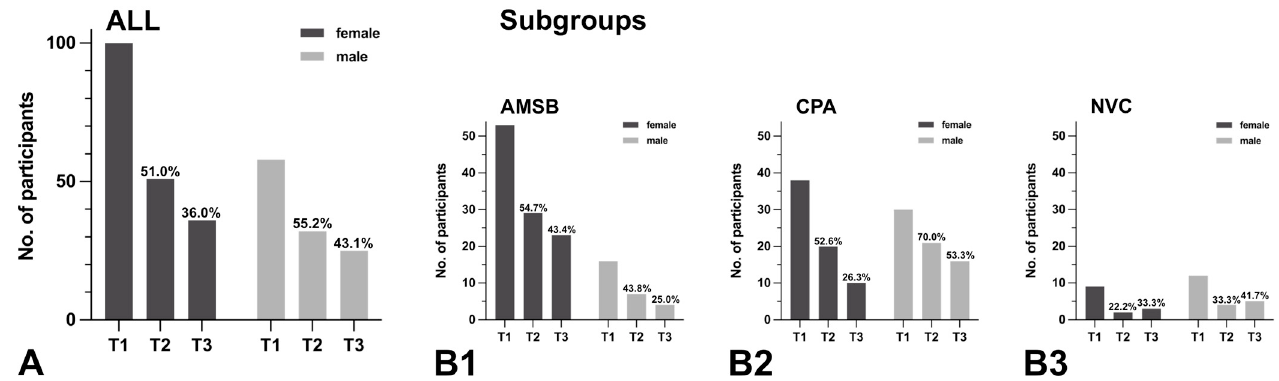
Figure 5. Evaluation of the response rate to PROMs depending on gender. ALL = total group, AMSB = subgroup “anterior and middle skull base”, CPA = subgroup “cerebellopontine angle”, NVC = subgroup “neurovascular conflict”, no. = number, T1 = initial assessment, T2 = follow-up assessment after 3 months, T3 = follow-up assessment after 12 months. A − B: Number of completed assessments T1, T2, and T3 in relation to gender among ALL ( A ) and the subgroups AMSB ( B1 ), CPA ( B2 ), or NVC ( B3 ) (the proportion of completed T2/T3 assessments in relation to the corresponding number of T1 assessments, sorted by gender, is presented as a percentage).